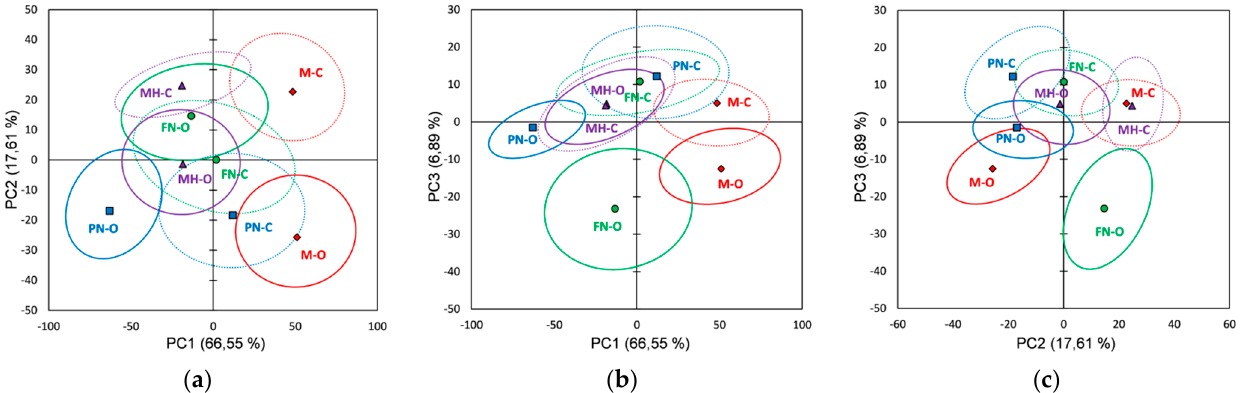
Figure 7. Score plots of the first three principal components derived from FTIR data of the red grape pulp extracts (the confidence ellipses are based and centered on bootstrap points): ( a ) PC1 vs. PC2 score plot; ( b ) PC1 vs. PC3 score plot; ( c ) PC2 vs. PC3 score plot.